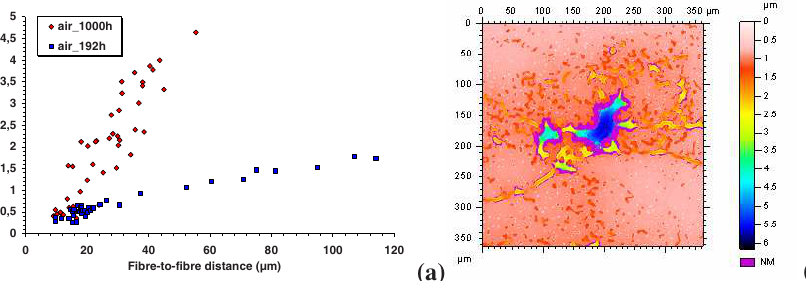
Fig. 4. a) Evolution of maximal matrix shrinkage depth as a function of the fibre-to-fibre distance in the composite sample isothermally aged at 150°C under atmospheric air 192h and 1000h and CIM topography of 1000h aged sample.